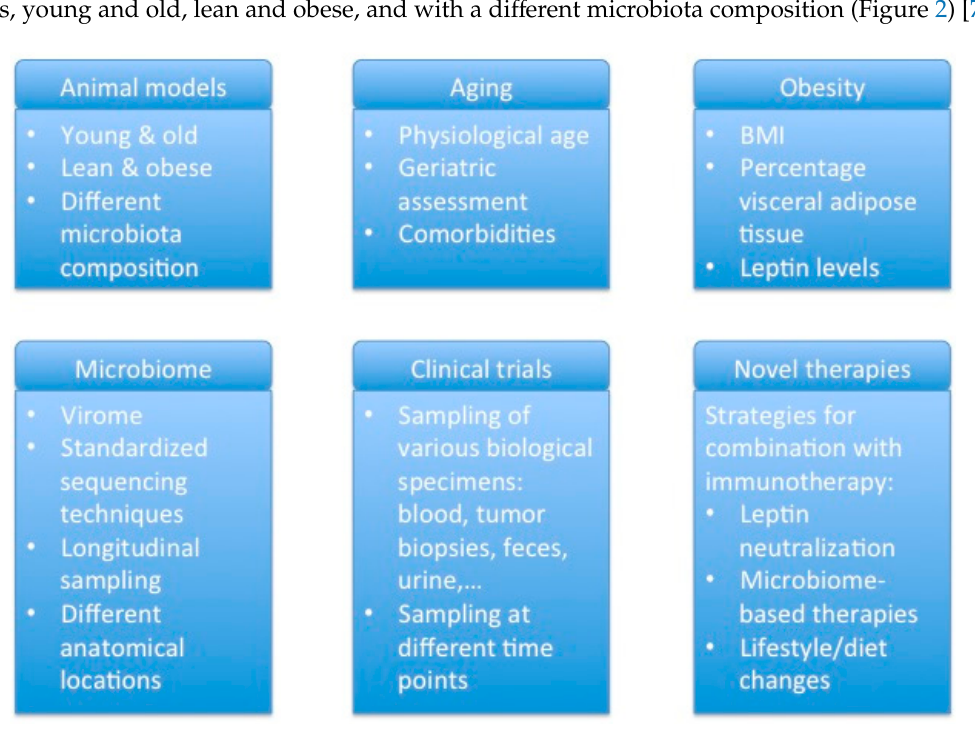
Figure 2. Suggestions for future research/clinical studies that aim to evaluate the effects of aging, obesity or the microbiota.